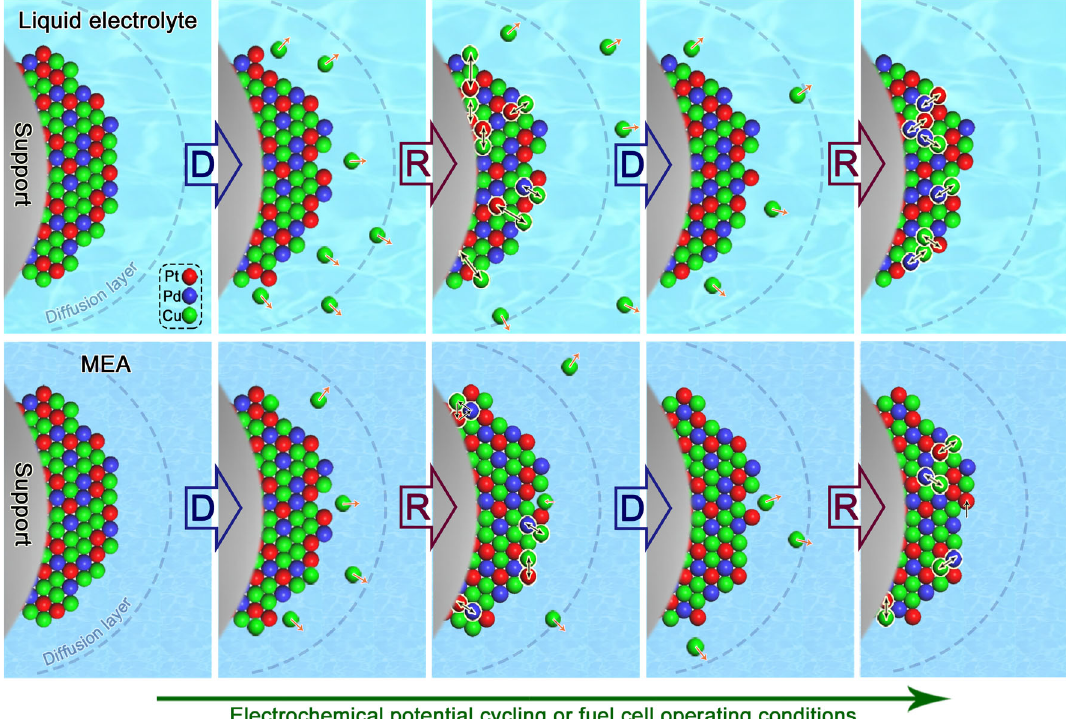
Fig. 6 A schematic diagram illustrating the realloying process in the NP upon dealloying. Top panel: in the electrochemical liquid cell; Bottom panel: in MEA of a fuel cell. D: Dealloying; R: Realloying. The difference between the liquid cell and MEA is that the diffusion of the dissolved Cu in MEA is much slower than that in the liquid cell, resulting in much slower dealloying kinetics. Note that the various parts in the illustration are drawn not to